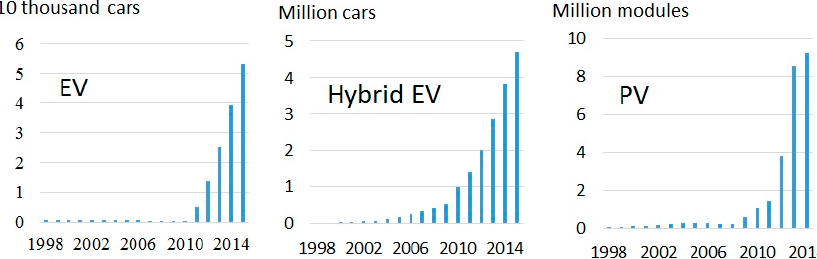
Figure 1. Number of vehicles owned ( left : EV; middle : hybrid EV; source: [20]) and production of PV modules for domestic use ( right ) in Japan (source: [21]).